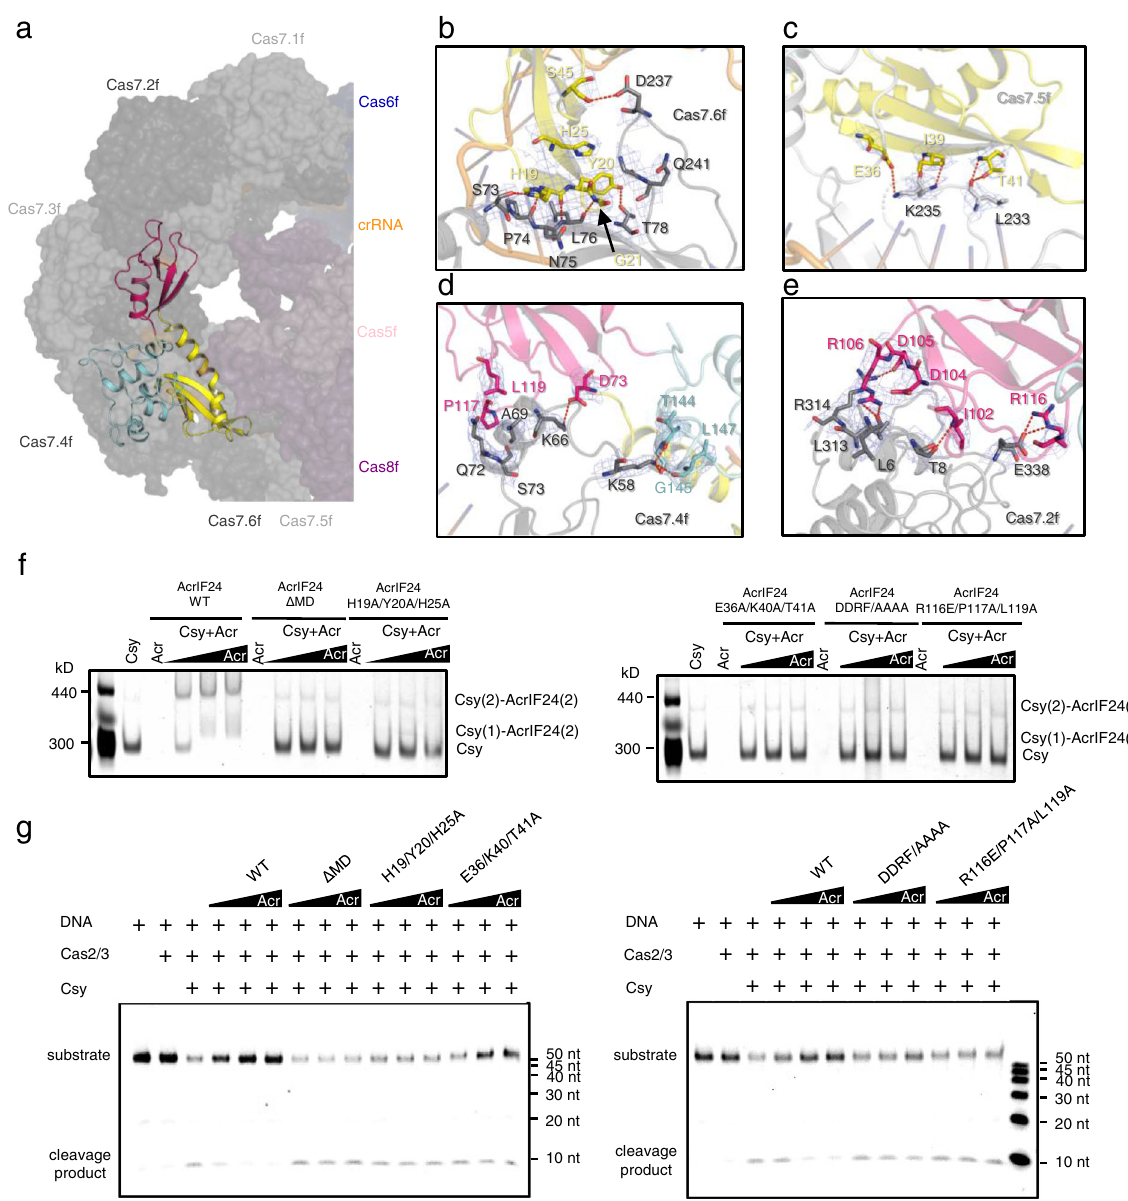
Fig. 4 Detailed interactions between AcrIF24 and the Csy complex, which is essential to the inhibition capacity. a Overall structure of the Csy-AcrIF24 complex with one AcrIF24 bound to one Csy complex. The Csy complex is shown in the surface model with each subunit colored as in Fig. 3d. AcrIF24 is shown in cartoon model colored in yellow, hot pink, and cyan for its NTD, MD, and CTD, respectively. b – e Close-up view of the interfaces between AcrIF24 and the Csy complex. The interfaces of AcrIF24 NTD -Cas7.6f ( b ), AcrIF24 NTD -Cas7.5f ( c ), AcrIF24 MD -Cas7.4f ( d ), and AcrIF24 MD -Cas7.2f ( e ) are shown. AcrIF24 is colored as in a, and interacting residues are shown as sticks with cryo-EM density map shown in mesh. f Native gel was used to test the binding between the Csy complex and AcrIF24 or its mutants. Reactions were performed with 0.32 μ M Csy complex and AcrIF24 concentrations of 0.16, 0.32, and 0.64 μ M following the order indicated by the black triangle. DDRF/AAAA represents the D104A/D105A/R106A/F107A mutant. The gel was stained with Coomassie blue staining. g Mutations of the interface residues of AcrIF24 decreased its inhibition capacity of the in vitro cleavage activity of the type I-F CRISPR system. Reactions are performed as in Fig. 1a. DDRF/AAAA represents the D104A/D105A/R106A/F107A